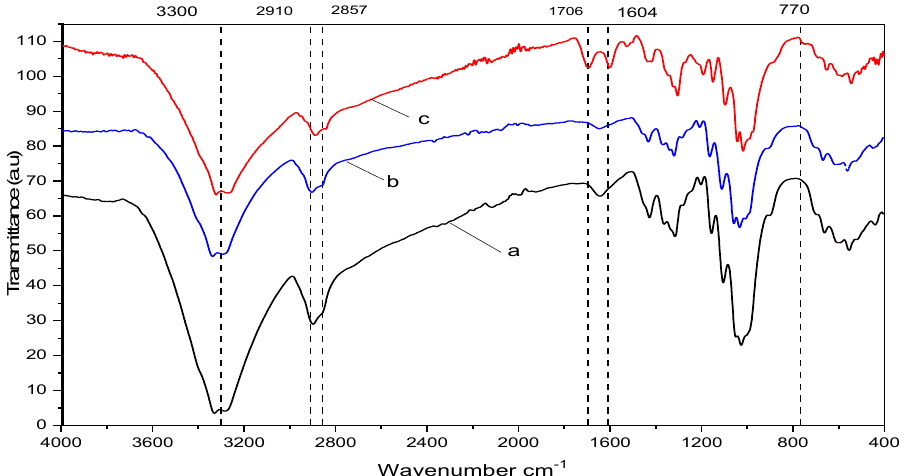
Figure 2. FTIR spectra of the treated fabrics. (a) Spectrum for blank cotton (b) cotton fabric modified with GPTMS-MWCNTs nanocomposite, and (c) cotton fabric modified with MWCNTs-GPTMS-tannic nanocomposite.